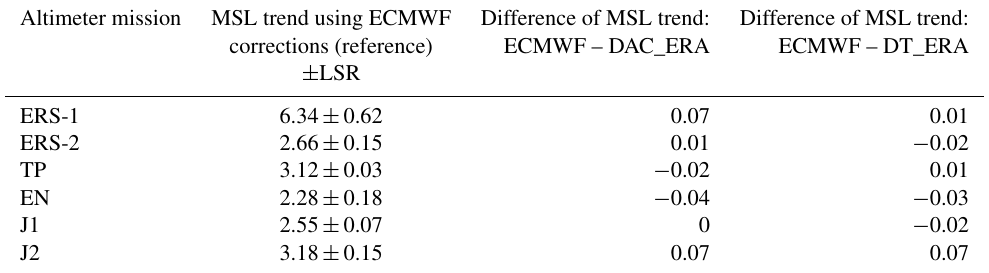
Table 2. Impact of ERA-Interim-based corrections (DAC_ERA and DT_ERA) on global MSL trends and the least square root estimation error (LSR) (mmyr − 1